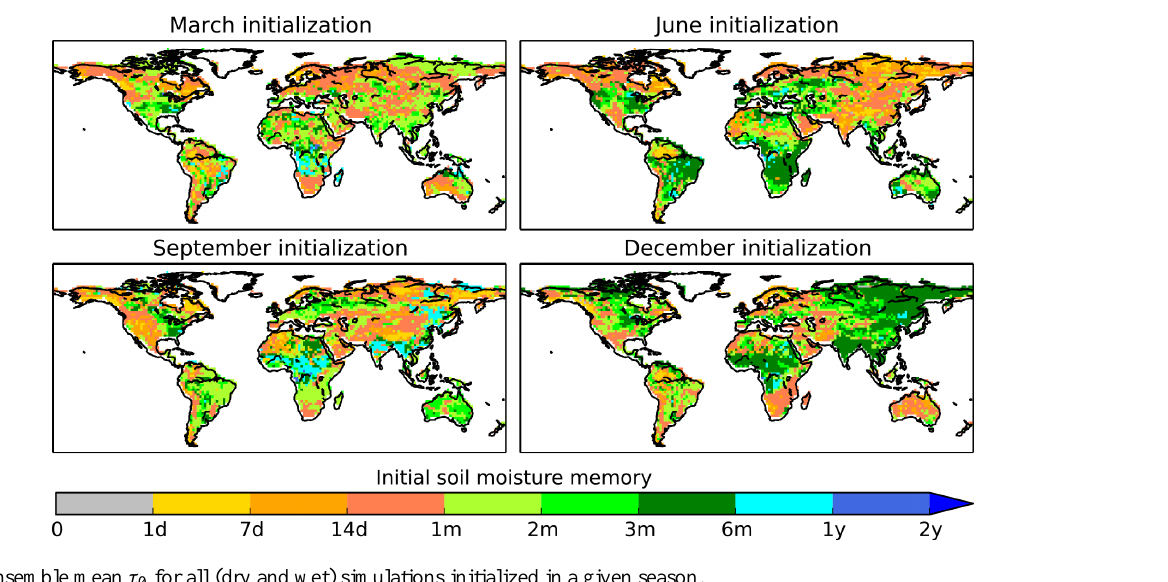
Figure 5. Ensemble mean τ 0 for all (dry and wet) simulations initialized in a given season.